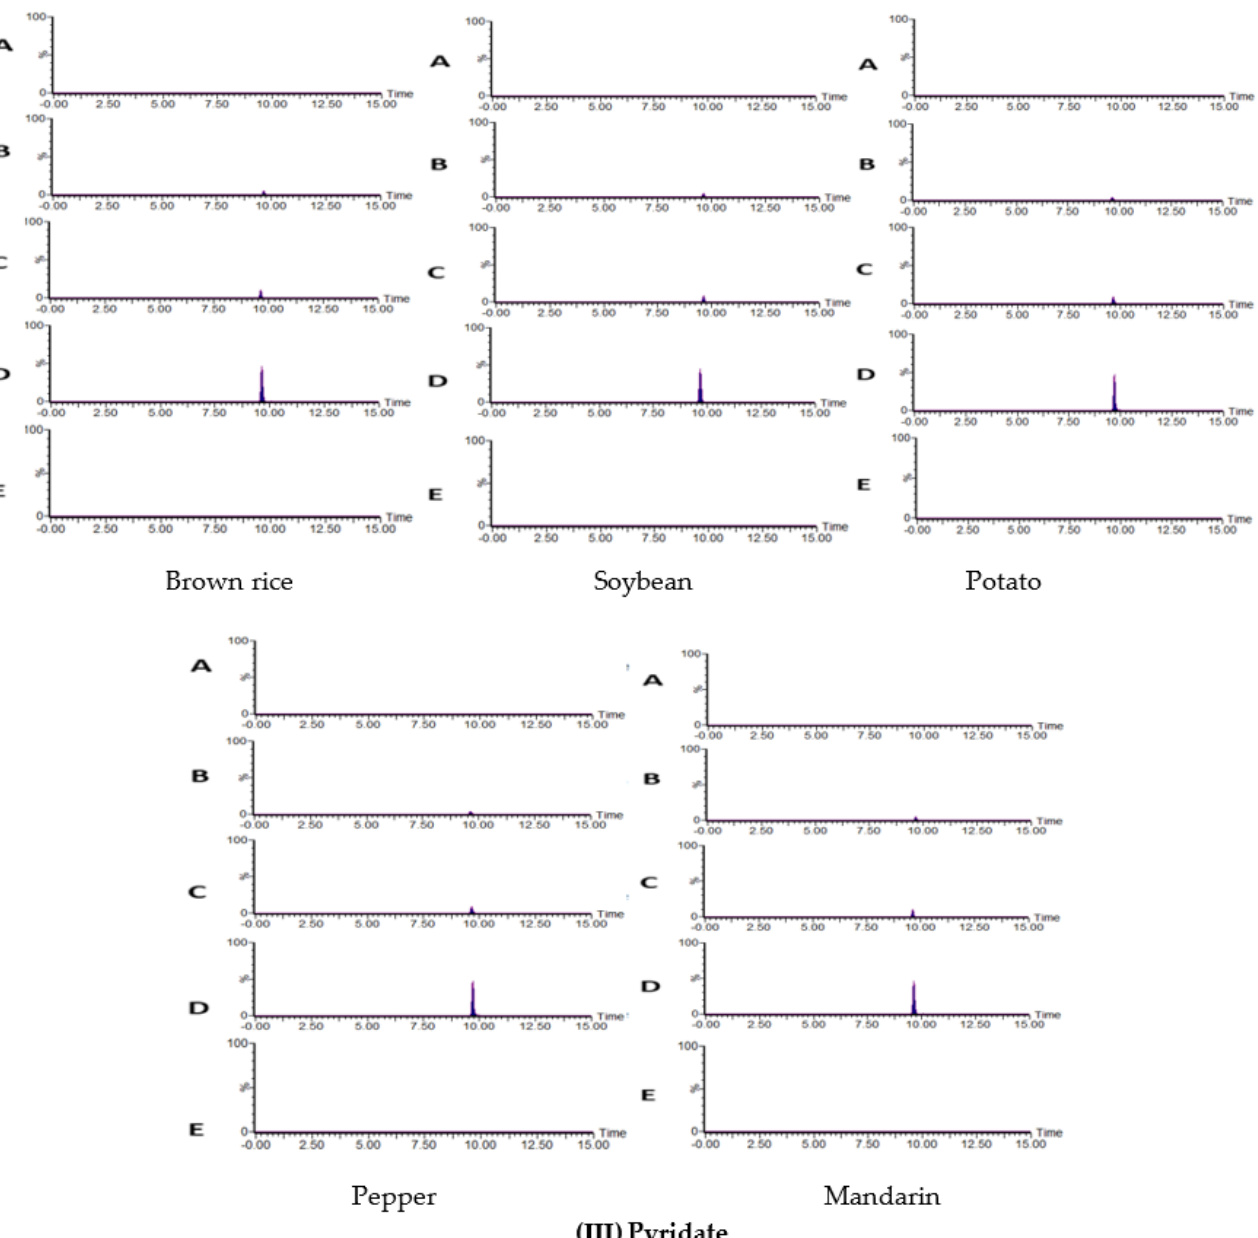
Figure 1. Representative MRM (quantification ion) chromatograms of ( Ⅰ ) cyhalofop-butyl, ( II ) quizalofop-ethyl, and ( III ) pyridate in five different matrices (brown rice, soybean, potato, pepper, and mandarin: ( A ) blank sample, ( B ) sample spiked at 0.005 mg/kg, ( C ) sample spiked at 0.01 mg/kg, ( D ) sample spiked at 0.2 mg/kg, and ( E ) market sample.